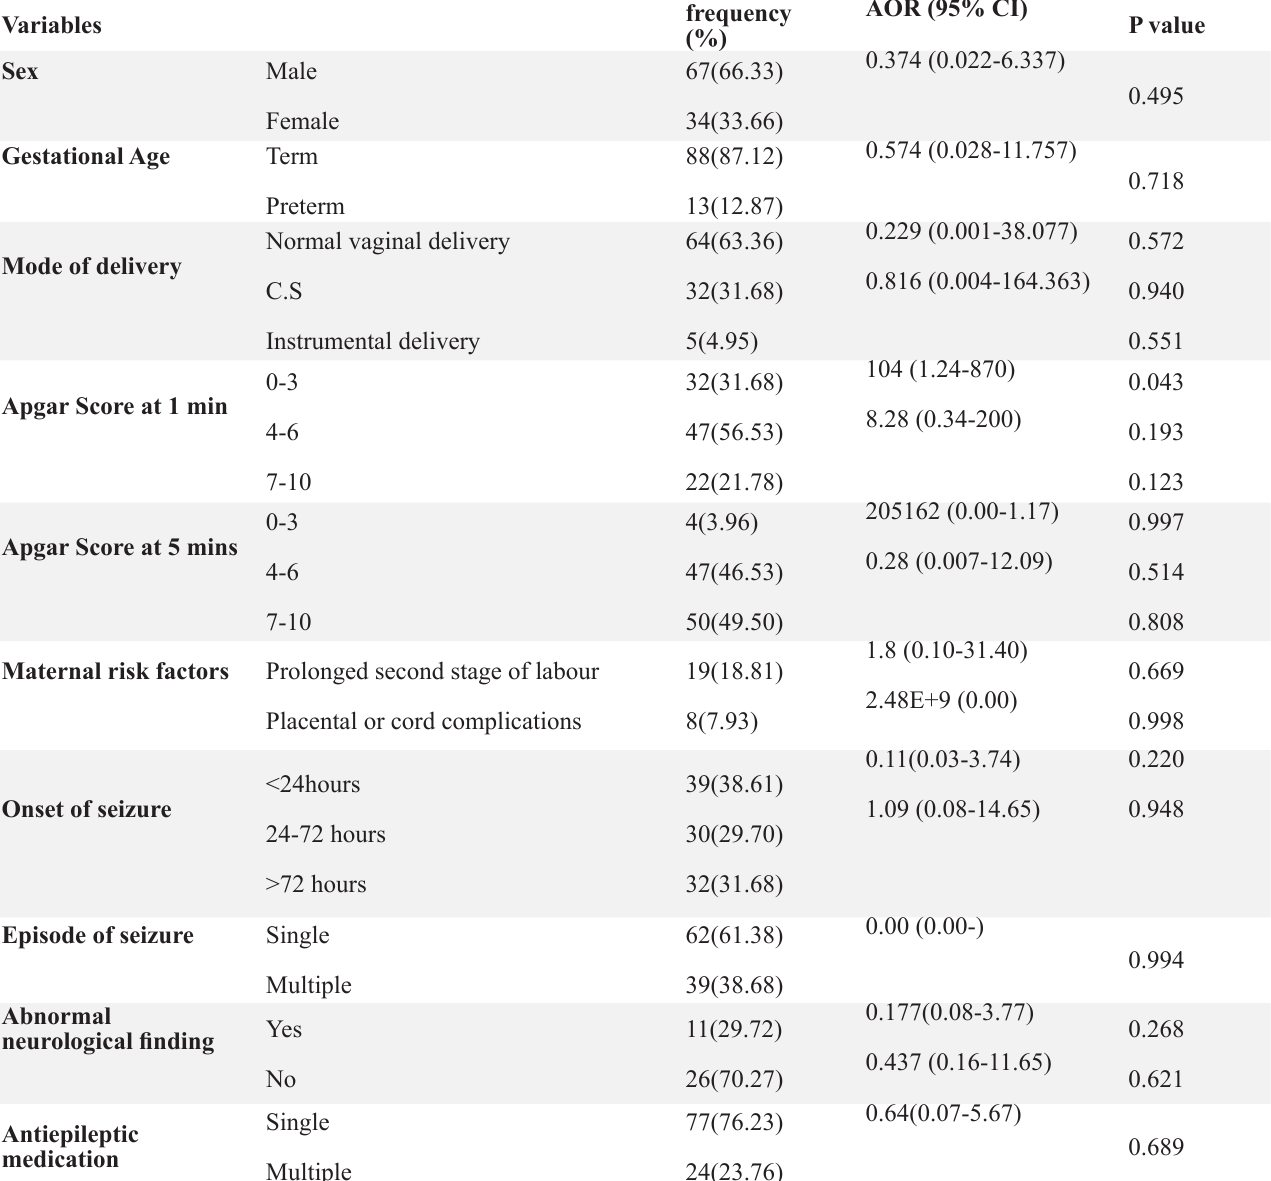
Table 3. Risk factors for post neonatal seizure (